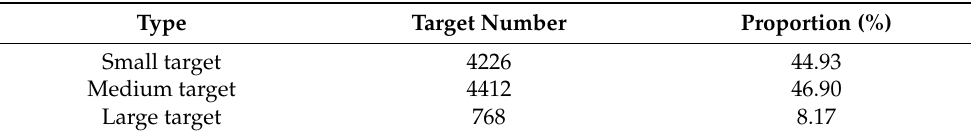
Figure 12. Annotation file.